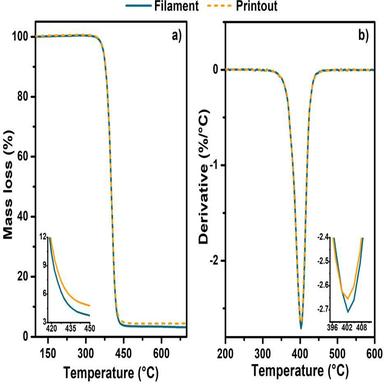
TG (a) and DTG (b) curves of Bioflex® filament and printout.